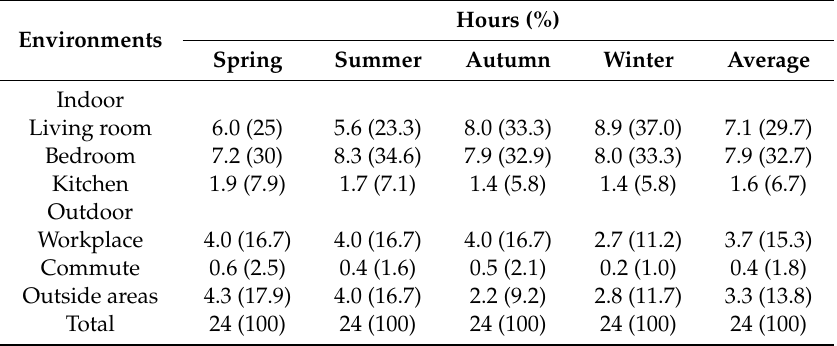
Table 3. Average periods spent by residents in di ff erent indoor and outdoor environments over two